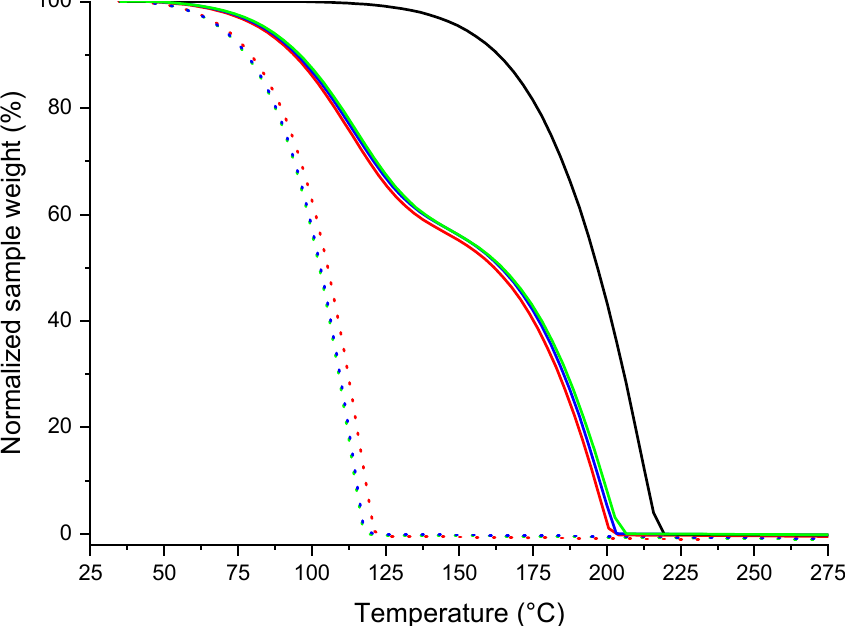
Figure 6. Thermogravimetric curves obtained for the Lido: DL M (red solid line), Lido: L M (green solid line), and Lido: D M (blue solid line) cocrystals. For comparison, the data were also collected for pure lidocaine (black solid line), racemic (red dotted line), levo- (green dotted line), and dextro- menthol (blue dotted line). Uncertainties: Δ x = 0.6 °C, and Δ y = 0.4%.